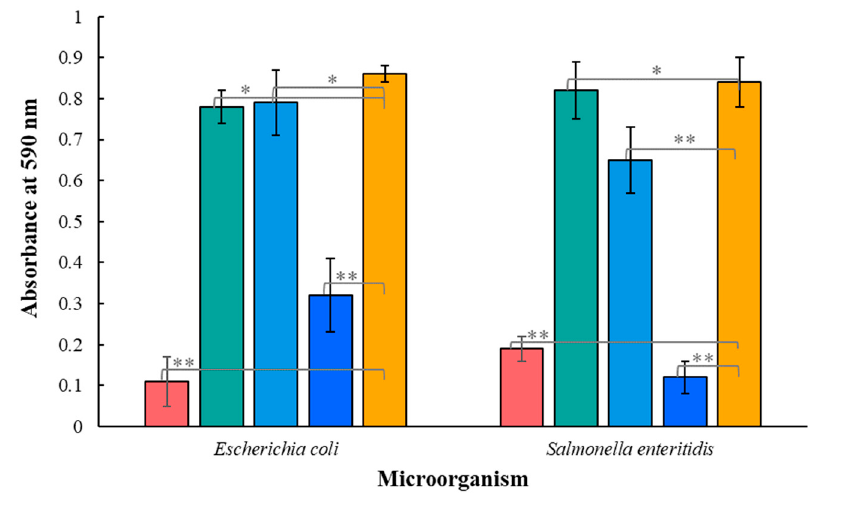
Figure 4. Effect of quercetin 3- O -rutinoside, quercetin 3- O -arabinoside and hesperidin on biofilm formation . The results are presented as the mean ± SE of the absorbance at 590 nm. Phytochemicals and streptomycin were used at a concentration of 2 µM. Data from three independent experiments are shown. One asterisk designates data of no significant difference, and two asterisks show data of statistically proven difference ( p < 0.001).